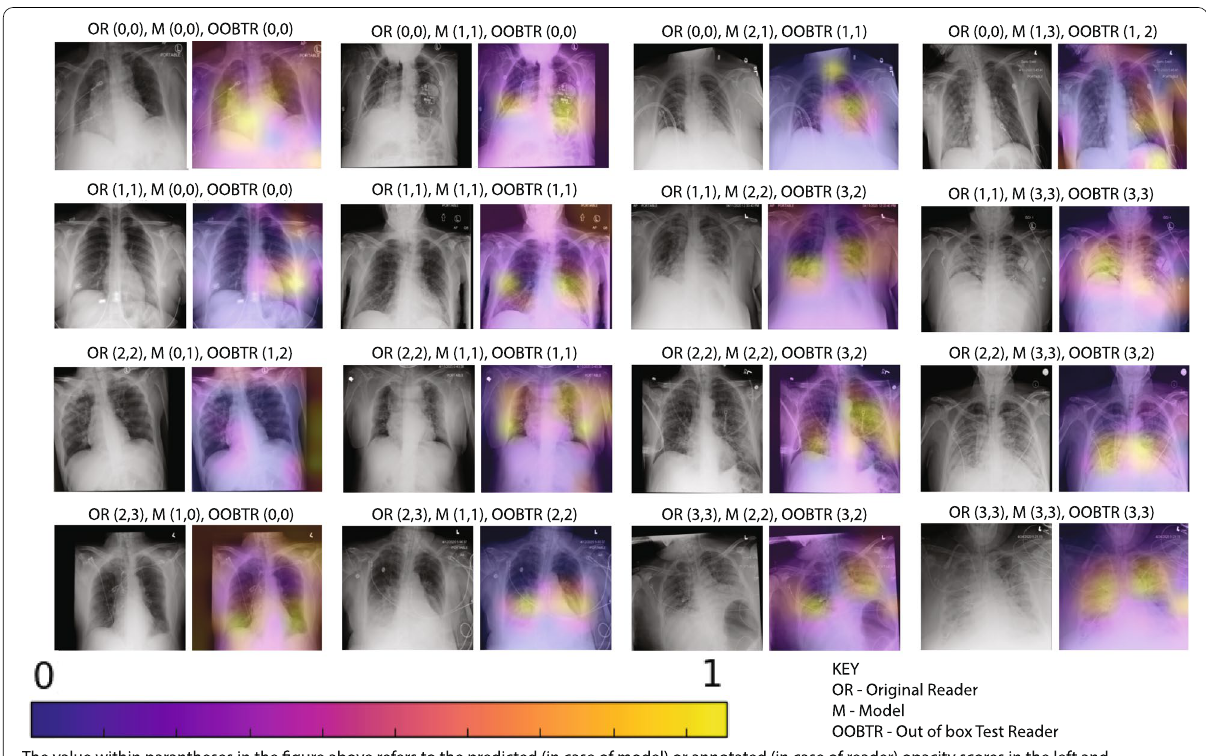
Fig. 3 Examples of generated heatmaps and classifications from the model, the OR, and the OOBTR. The value within the parantheses in the figure refers to the predicted (in case of model) or annotated (in case of reader) opacity scores for the left and right lungs respectively. For example, OR (2,3) indicates an Original Reader (OR) CXR opacity score of 2 for the left lung, and 3 for the right